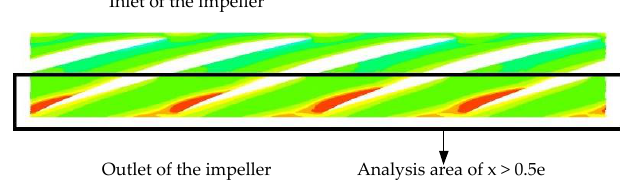
Figure 15. Analysis area of the gas distribution at 10% of the blade height.